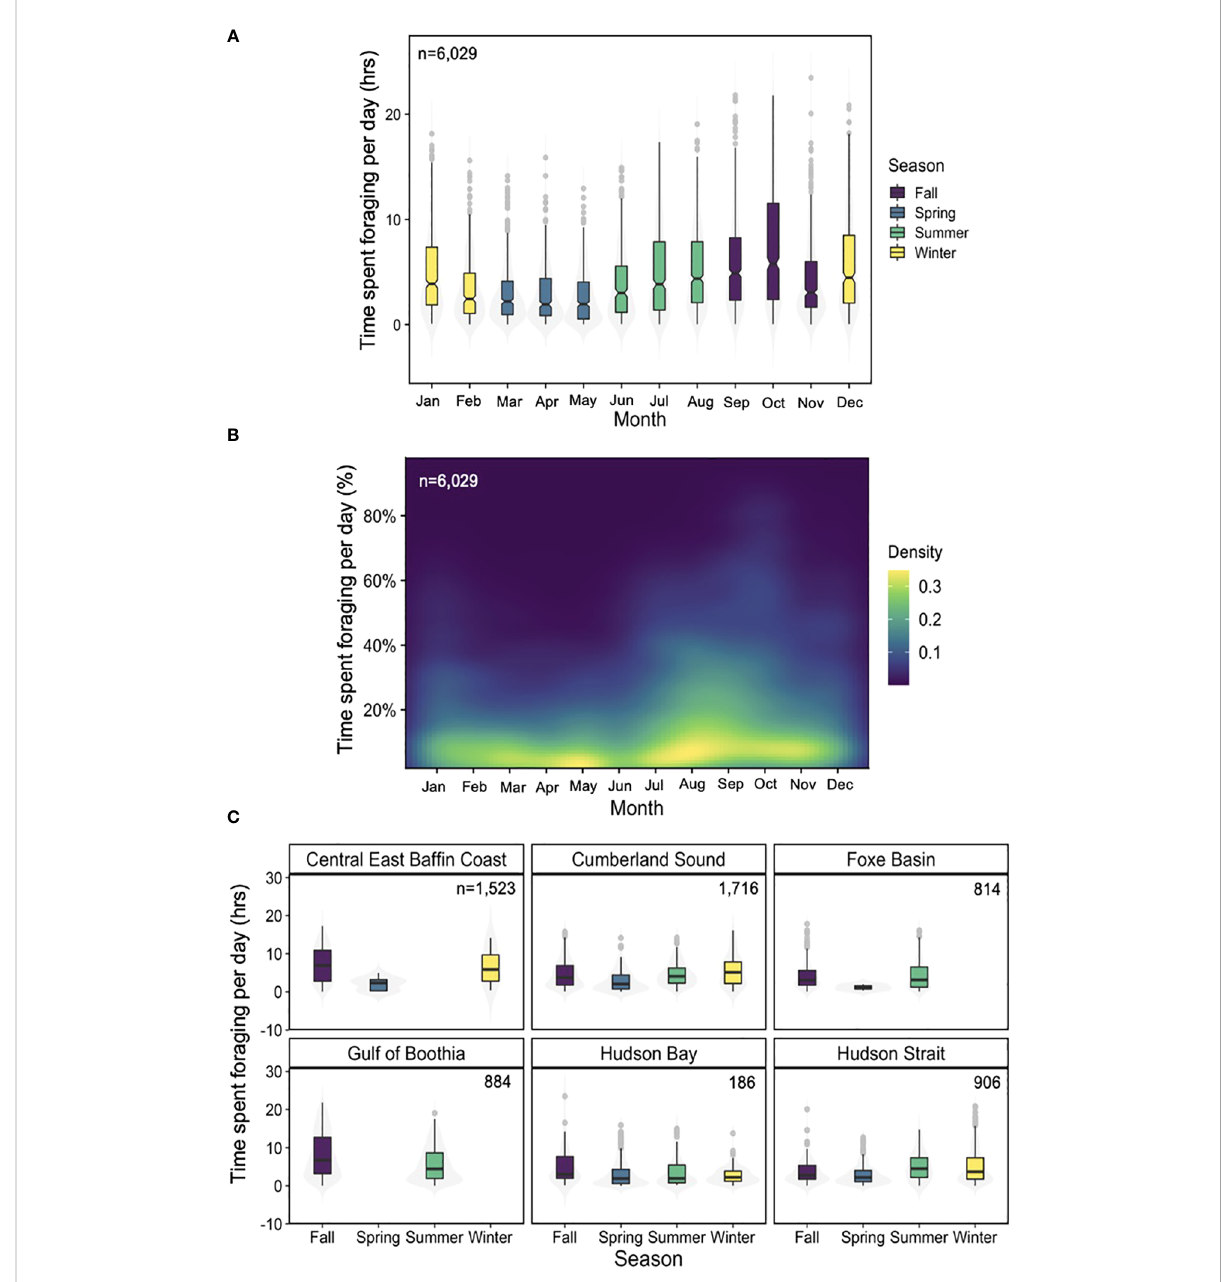
FIGURE 6 (A) Total time spent conducting putative foraging dives (square-shaped) daily by month with data pooled across individuals (n=25) and years (n=4). Data are colour coded based on season whereby purple = fall, blue = spring, green= summer and yellow= winter. (B) heatmap of the proportion of time (24hrs) spent foraging per day based on the total daily proportion of time spent conducting square-shaped dives. Data pooled across individuals and years. Cool colors (purple) indicate low density of data points and warm colors (yellow) represent comparatively high densities of data. (C) Total time spent conducting putative foraging dives by region and season with data pooled across individuals and years. Boxplots include notches to indicate potential signi fi cant differences (when notches do not overlap) between months (A) and seasons (B) and violin plots (grey shaded area) shows the data